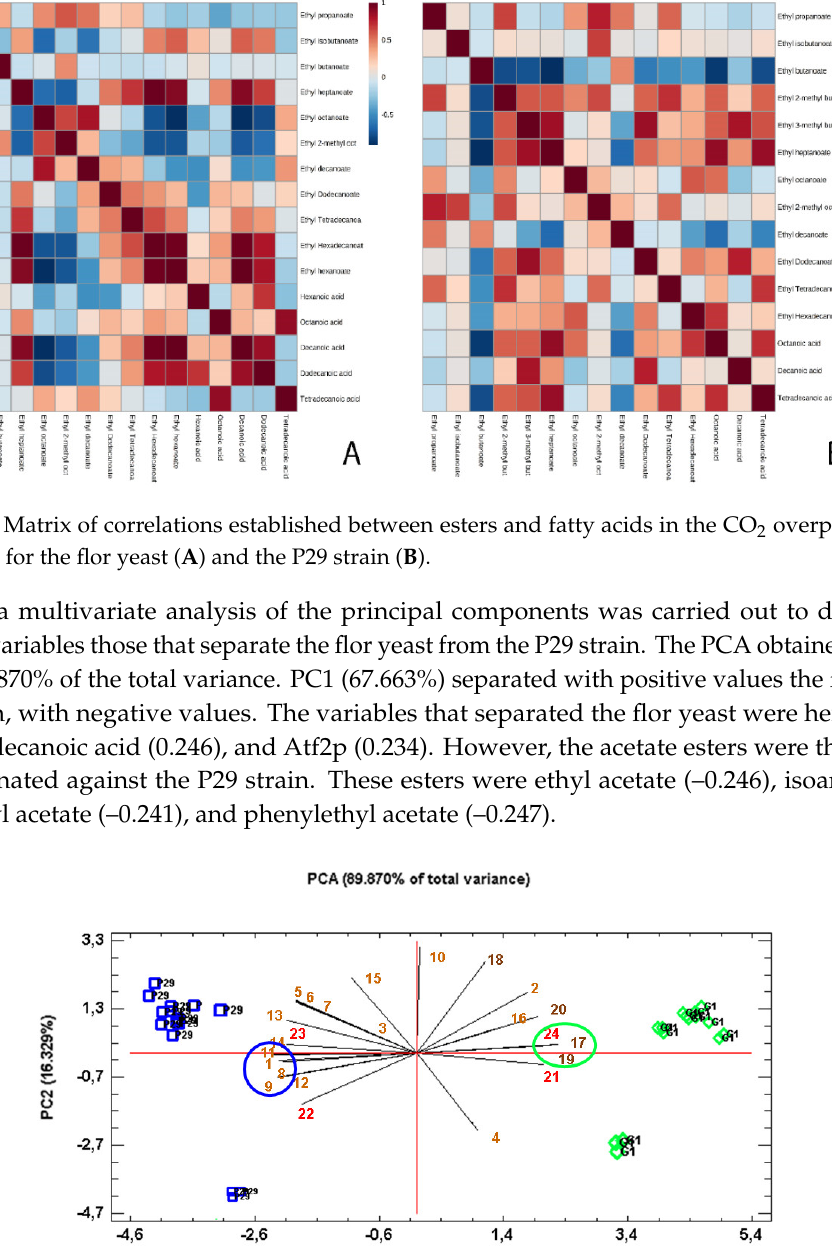
Figure 5. Matrix of correlations established between esters and fatty acids in the condition without CO 2 overpressure for flor yeast ( A ) and the P29 strain ( B ).